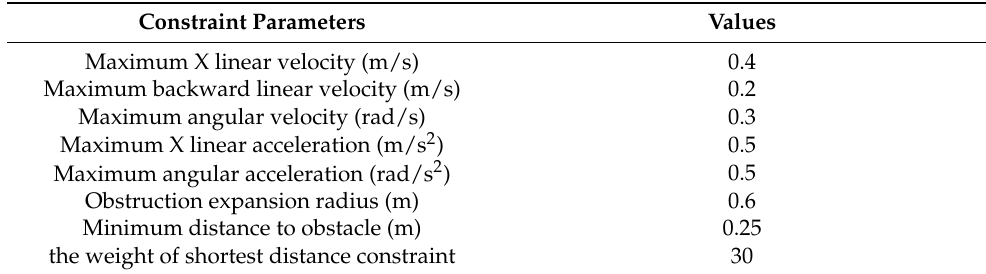
Table 1. Parameter configuration of the simulated